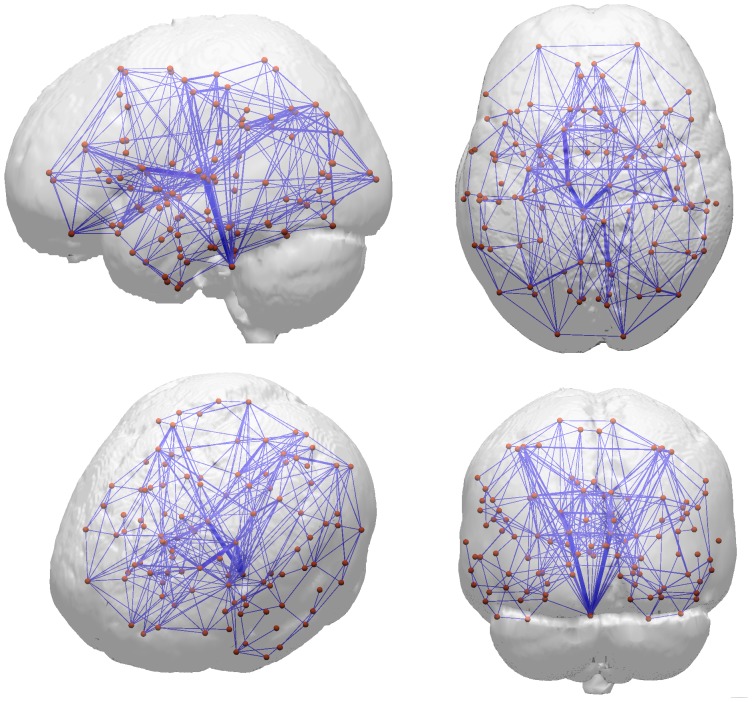
Structural network reconstructed in a male subject aged 73 years.Network nodes are shown as spheres that correspond to brain areas as defined by the Harvard-Oxford atlas. Connections are shown as blue lines, where wider lines indicate higher edge weights.